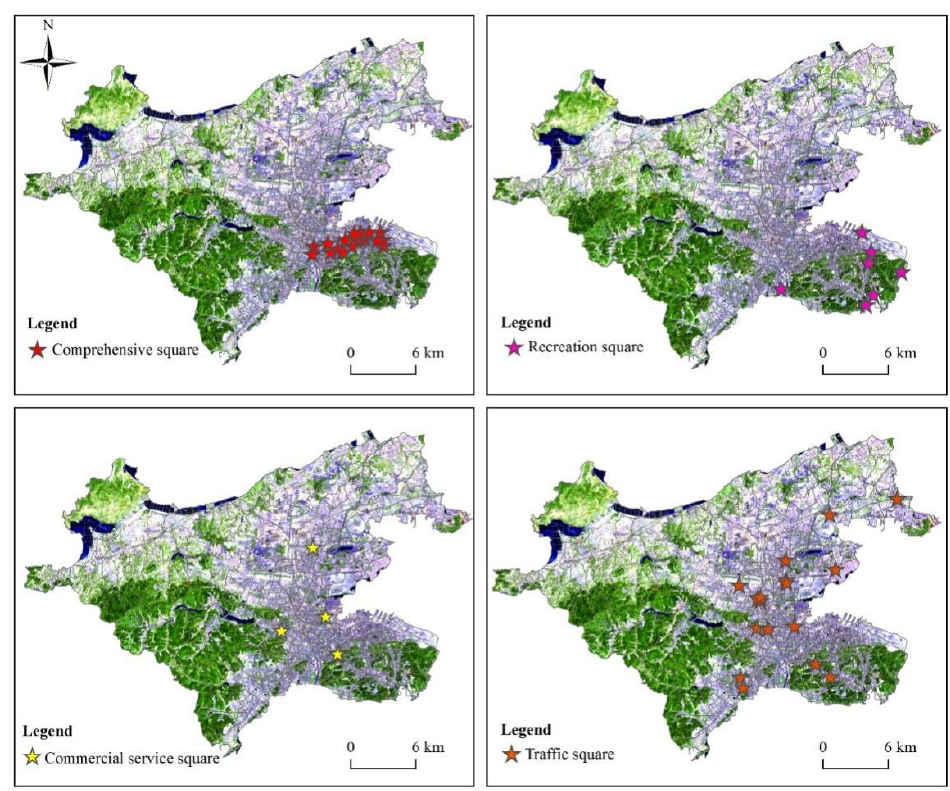
Figure 2. City squares classification spatial distribution. Table 6. Classification of city squares based on the perspective of human settlements.